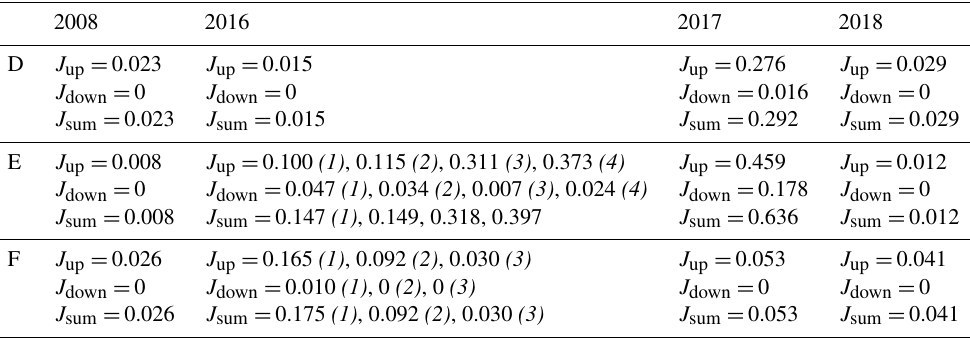
Table C1. Diffusive fluxes of dissolved inorganic phosphorus. The fluxes are calculated from pore water profiles, values are given in mmolm − 2 d − 1 . The 2008 values are calculated from profiles from Viktorsson et al. (2013). When there are results from multiple cores, the core number is given in brackets and italic font. For profiles that displayed production peaks, both the upward flux ( J up ) and the down- ward flux ( J down ) from that peak are